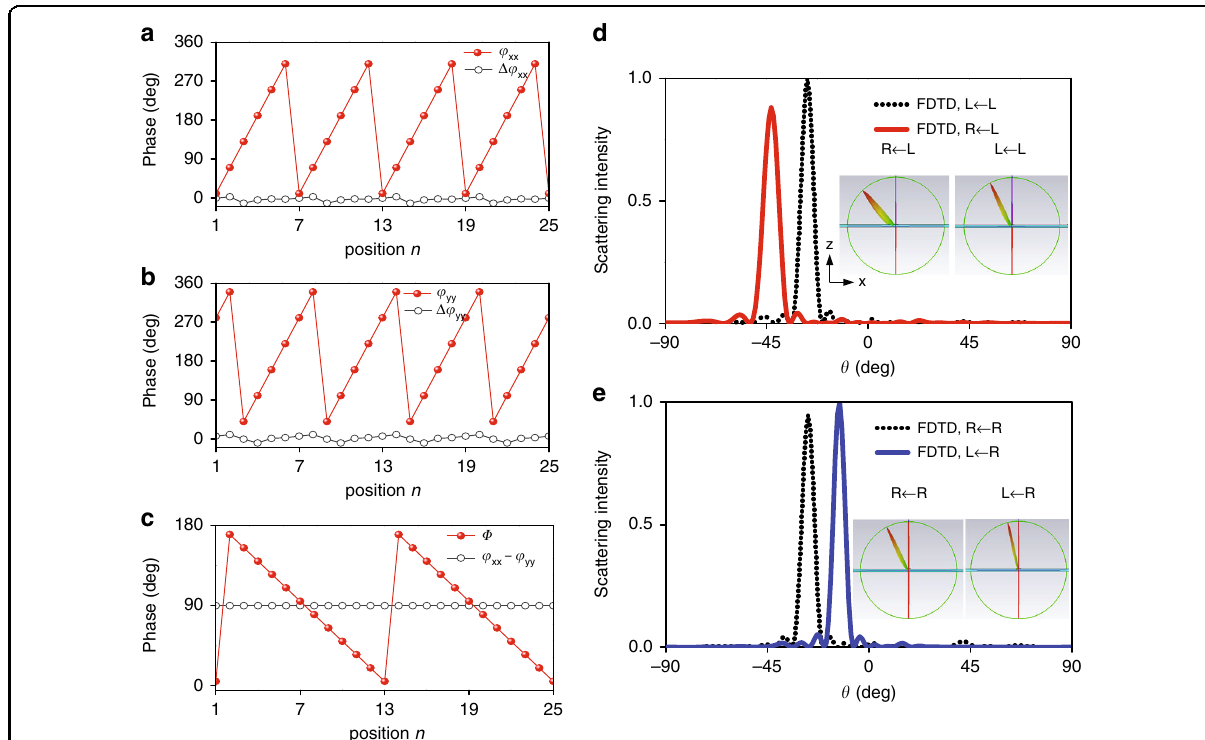
Fig. 3 FDTD characterization of spin-multiplexed quad-channel multi-beam generator. Required birefringent dynamic phases a φ xx and b φ yy of fi nally utilized meta-atoms, and practical near-zero phase tolerance pro fi le of Δ φ xx and Δ φ yy under a x - and b y -polarized wave, respectively. Here, Δ φ Δ φ xx and yy are deviations between theoretically calculated phases and those of practically utilized meta-atoms, indicating negligible phase errors. c Required half geometric phase, and phase difference between φ xx and φ yy . FDTD calculated 3D and 2D cross-section scattering patterns at 10 GHz impinged by d LCP and e RCP wave,